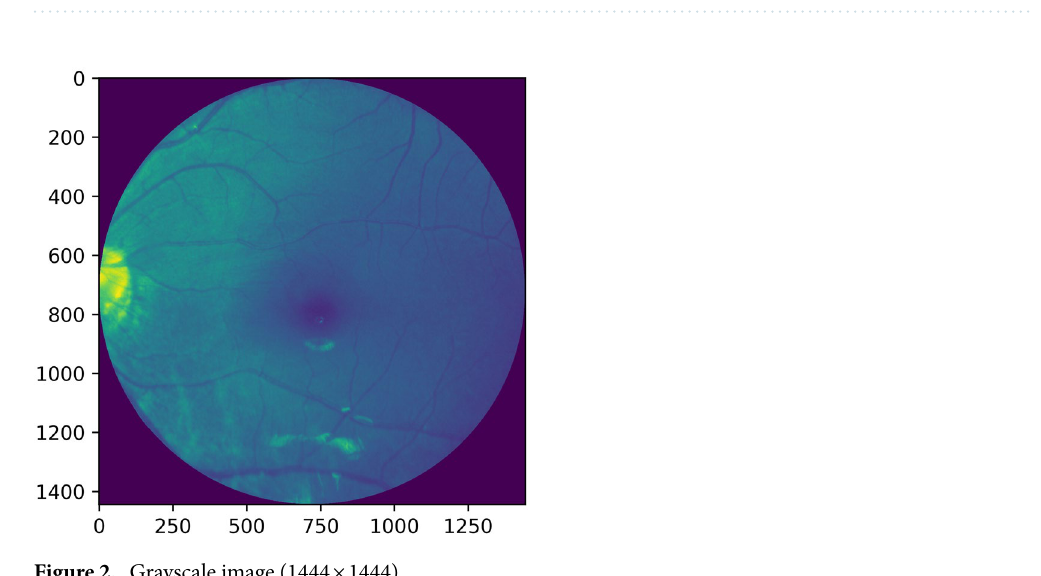
Figure 1. Original image (1444 × 1444 × 3) 14 .